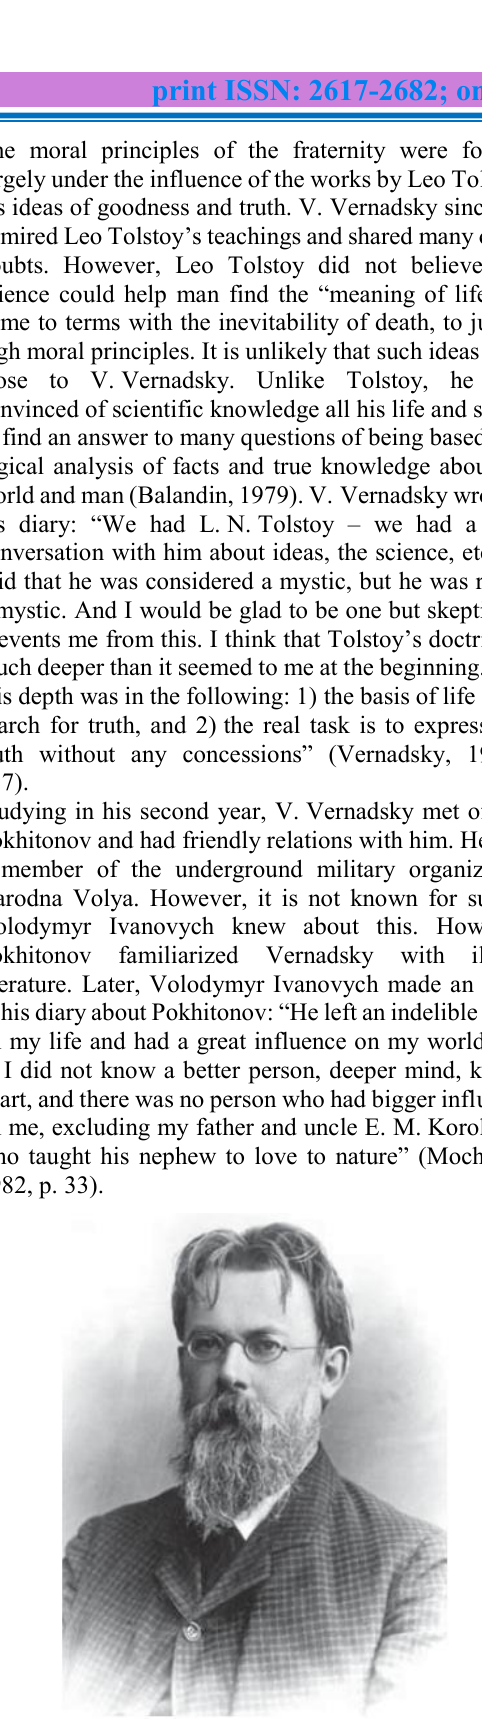
Figure 6. Volodymyr Ivanovych